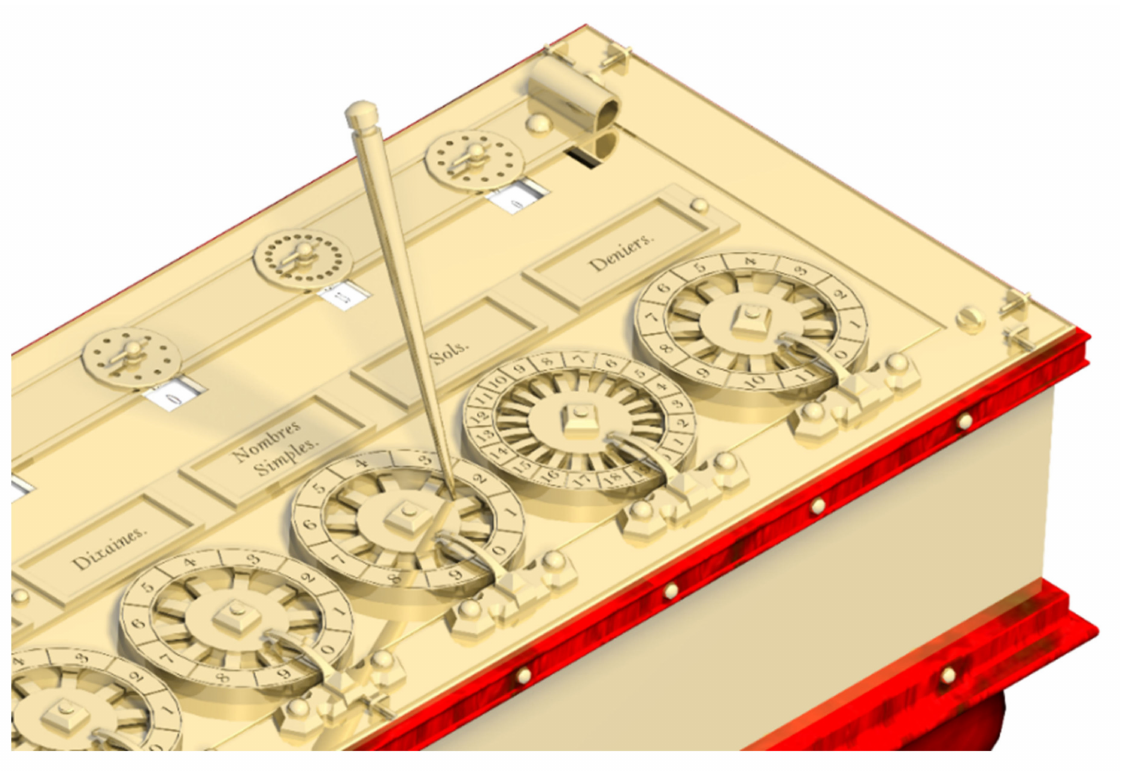
Figure 5. Addend input